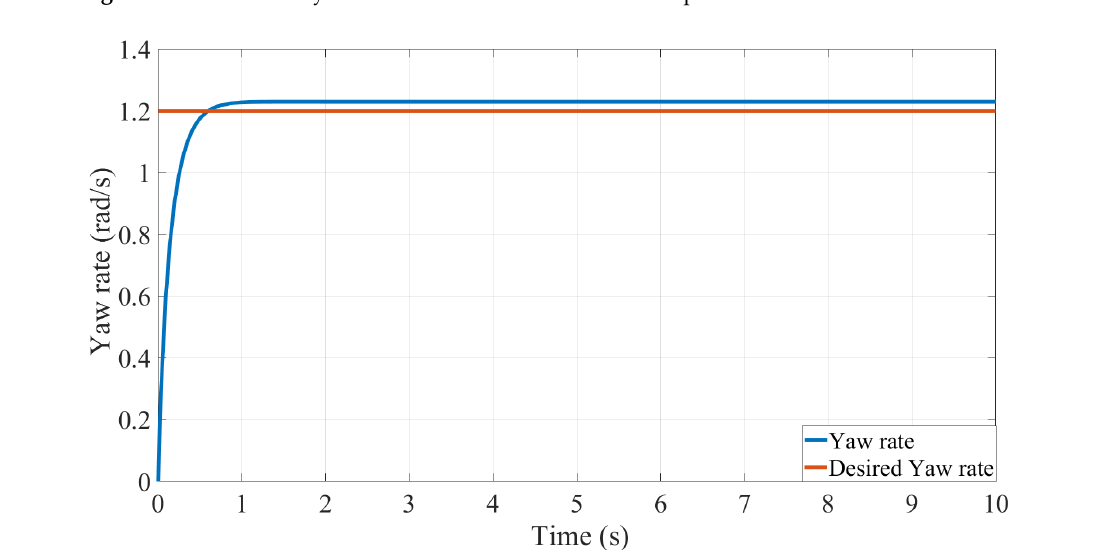
Figure 6. Uncontrolled yaw rates with no disturbance sine input.